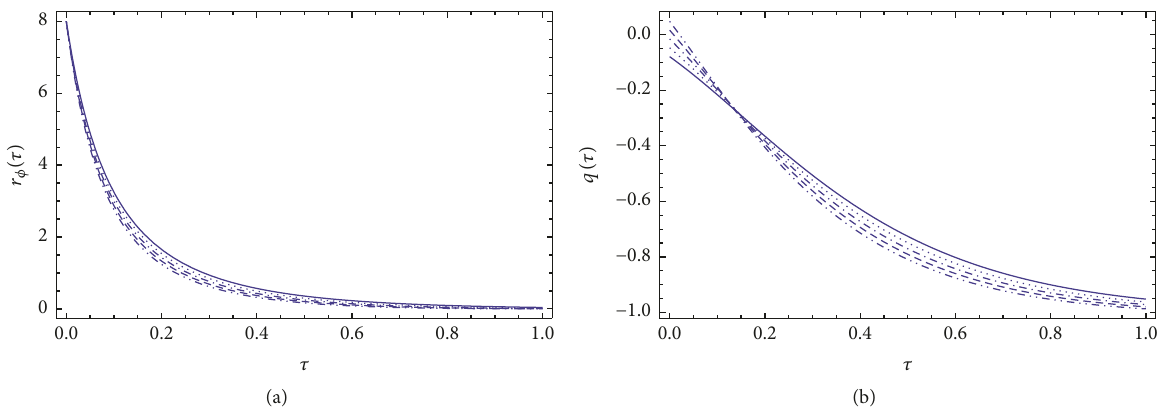
Figure 4: Time variation of the energy density of the scalar field with a small power law potential (a) and of the deceleration parameter (b) during the reheating period in the presence of irreversible matter creation, for different values 𝛼 𝜙 of the decay width of the scalar field: 𝛼 = 0.15 (solid curve), 𝛼 = 0.30 (dotted curve), 𝛼 = 0.45 (dash dotted curve), 𝛼 = 0.60 (dashed curve), and 𝛼 = 0.75 (dash double 𝜙 𝜙 𝜙 𝜙 𝜙 dotted curve), respectively. For 𝑝 we have adopted the value 𝑝 = 3 , while 𝜇 = 10 3 . The initial conditions used to numerically integrate (99) are 𝜙(0) = 1 , 𝑢(0) = −4 , 𝑁 𝜙 (0) = 5 , 𝑟 DM (0) = 0 , and 𝑟 m (0) = 0 ,